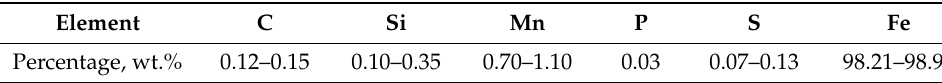
Figure 2. Electrochemical cell and disk work electrode. Table 2. The steel composition of the working electrode.